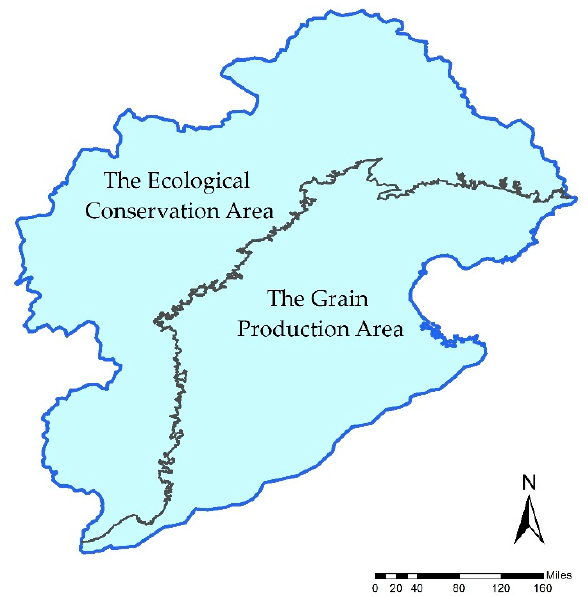
Figure 2. Division of the Haihe Basin into two areas.